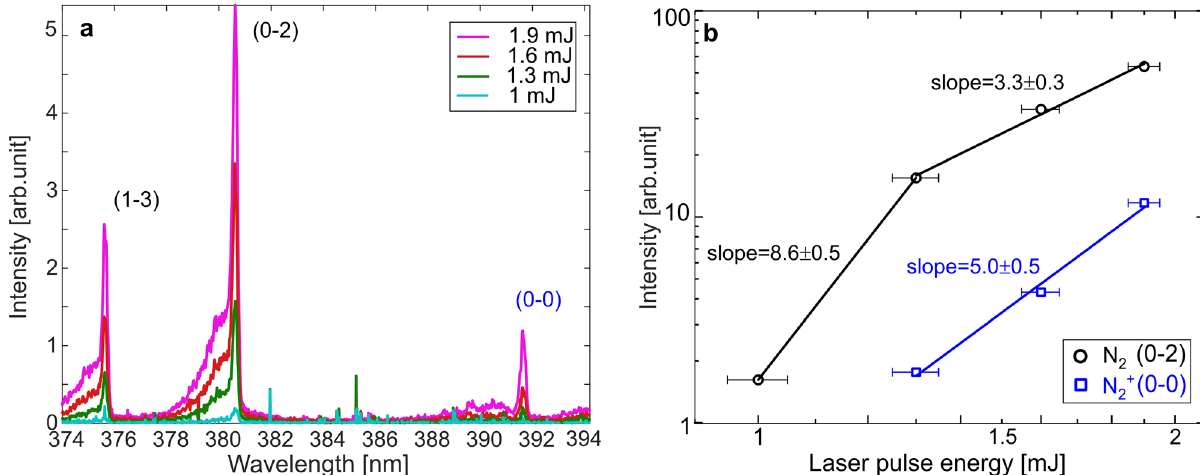
+ Figure 5. ( a ) High-resolution N 2 and N 2 fluorescence spectra with vibrational bands of the transitions B 2 (cid:31) + → B 3 (cid:31) → X 2 (cid:31) + g and g recorded at different pulse energies. ( b ) Power dependence of the u 3 (cid:31) N + → B 3 (cid:31) signal for C 2 fluorescence signal for u g (0–2) transition and